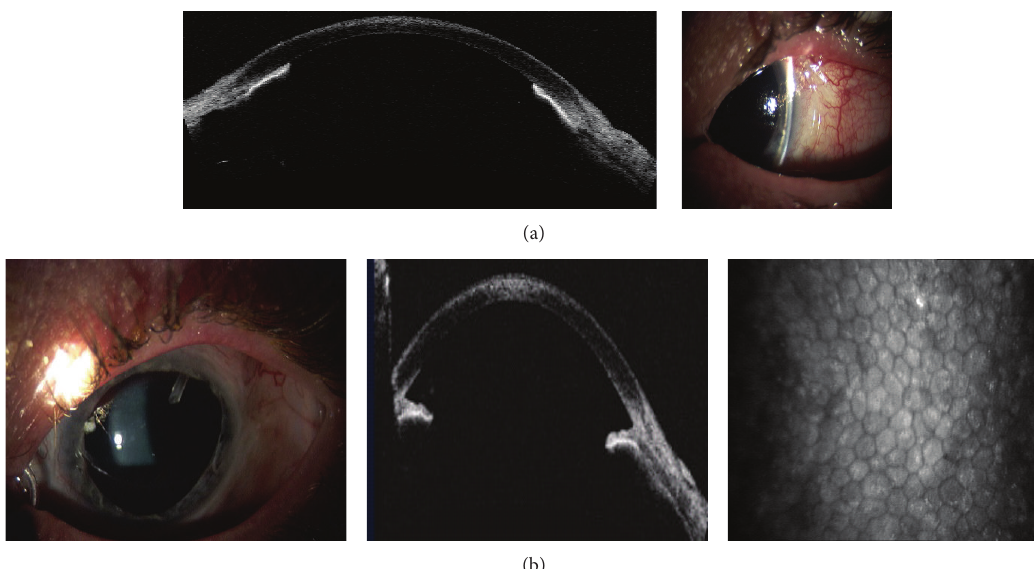
Figure 10: (a) A 360 degree iridocorneal adhesion after ocular injury. (b) Approximately six months later after surgical